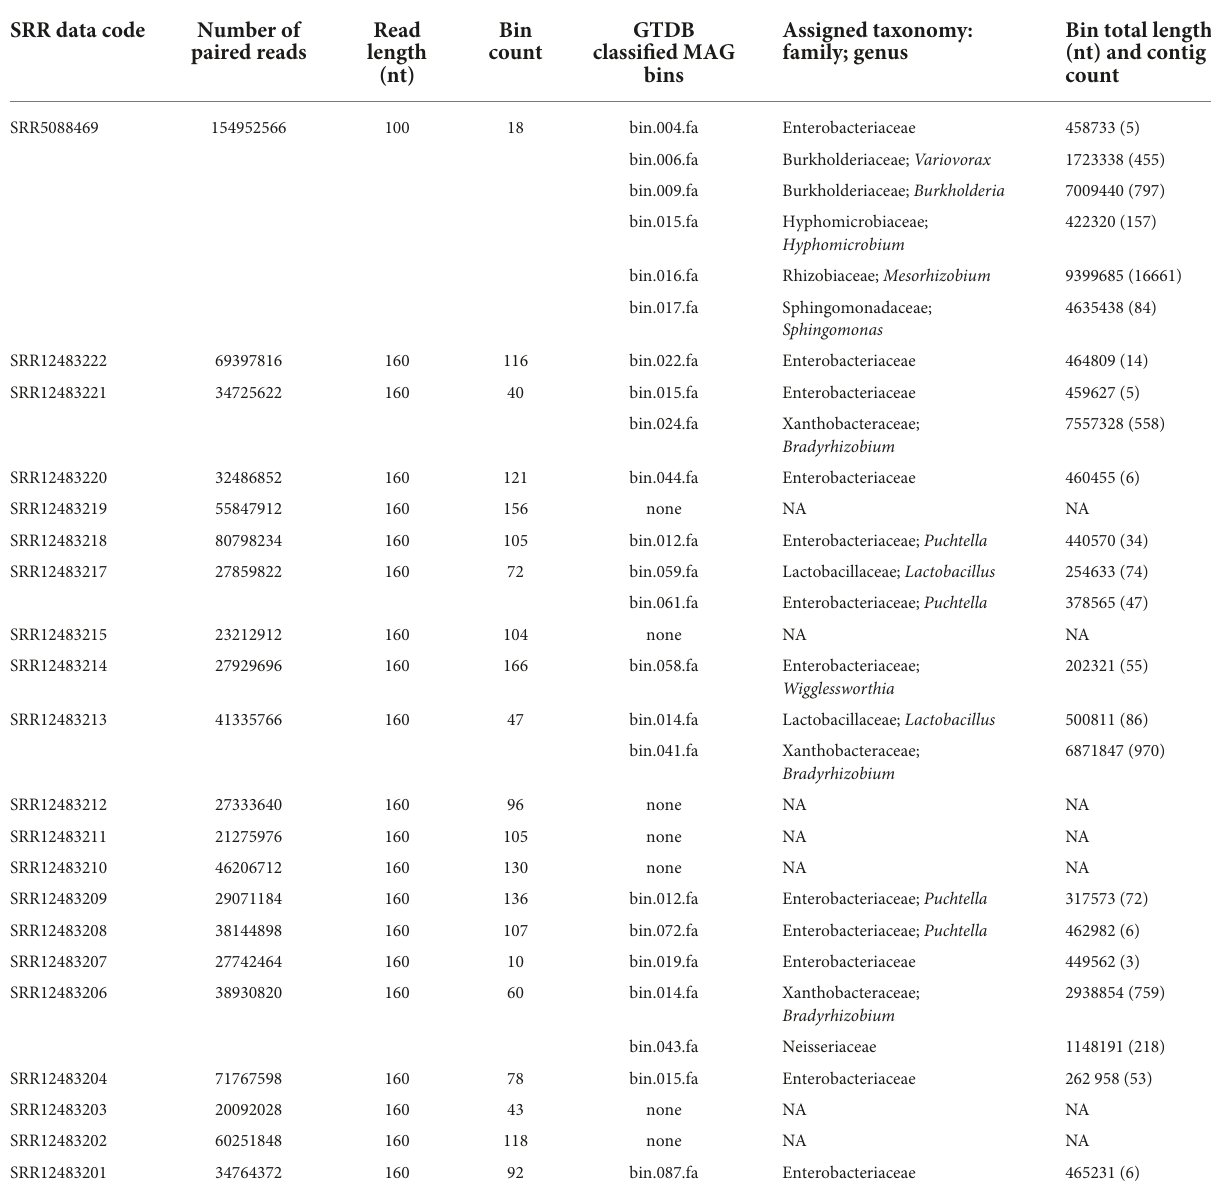
TABLE 1 Overview of metagenomic binning and taxonomy assignment. SRR data